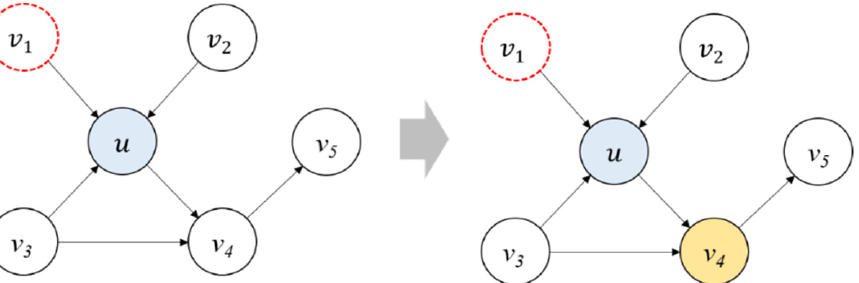
Figure 5. Vertices collected during incremental processing.